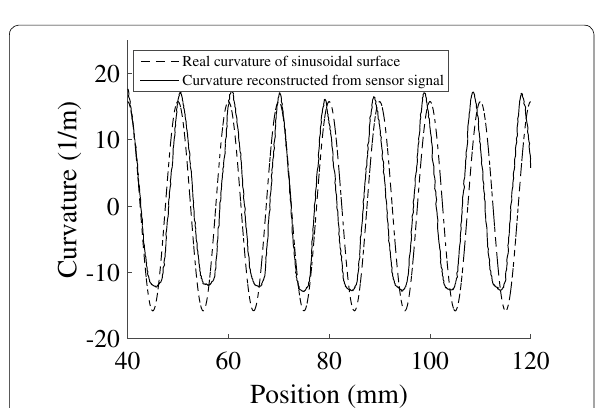
Fig. 14 This graph shows the output signal when a sinusoidal surface with an amplitude of 40 µ m and a spatial period of 10 mm is traced by the proposed